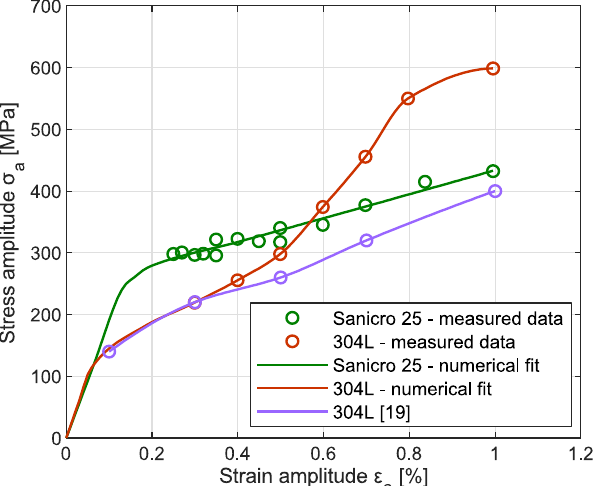
Figure 3. Experimentally measured and numerically modeled cyclic stress–strain curves.